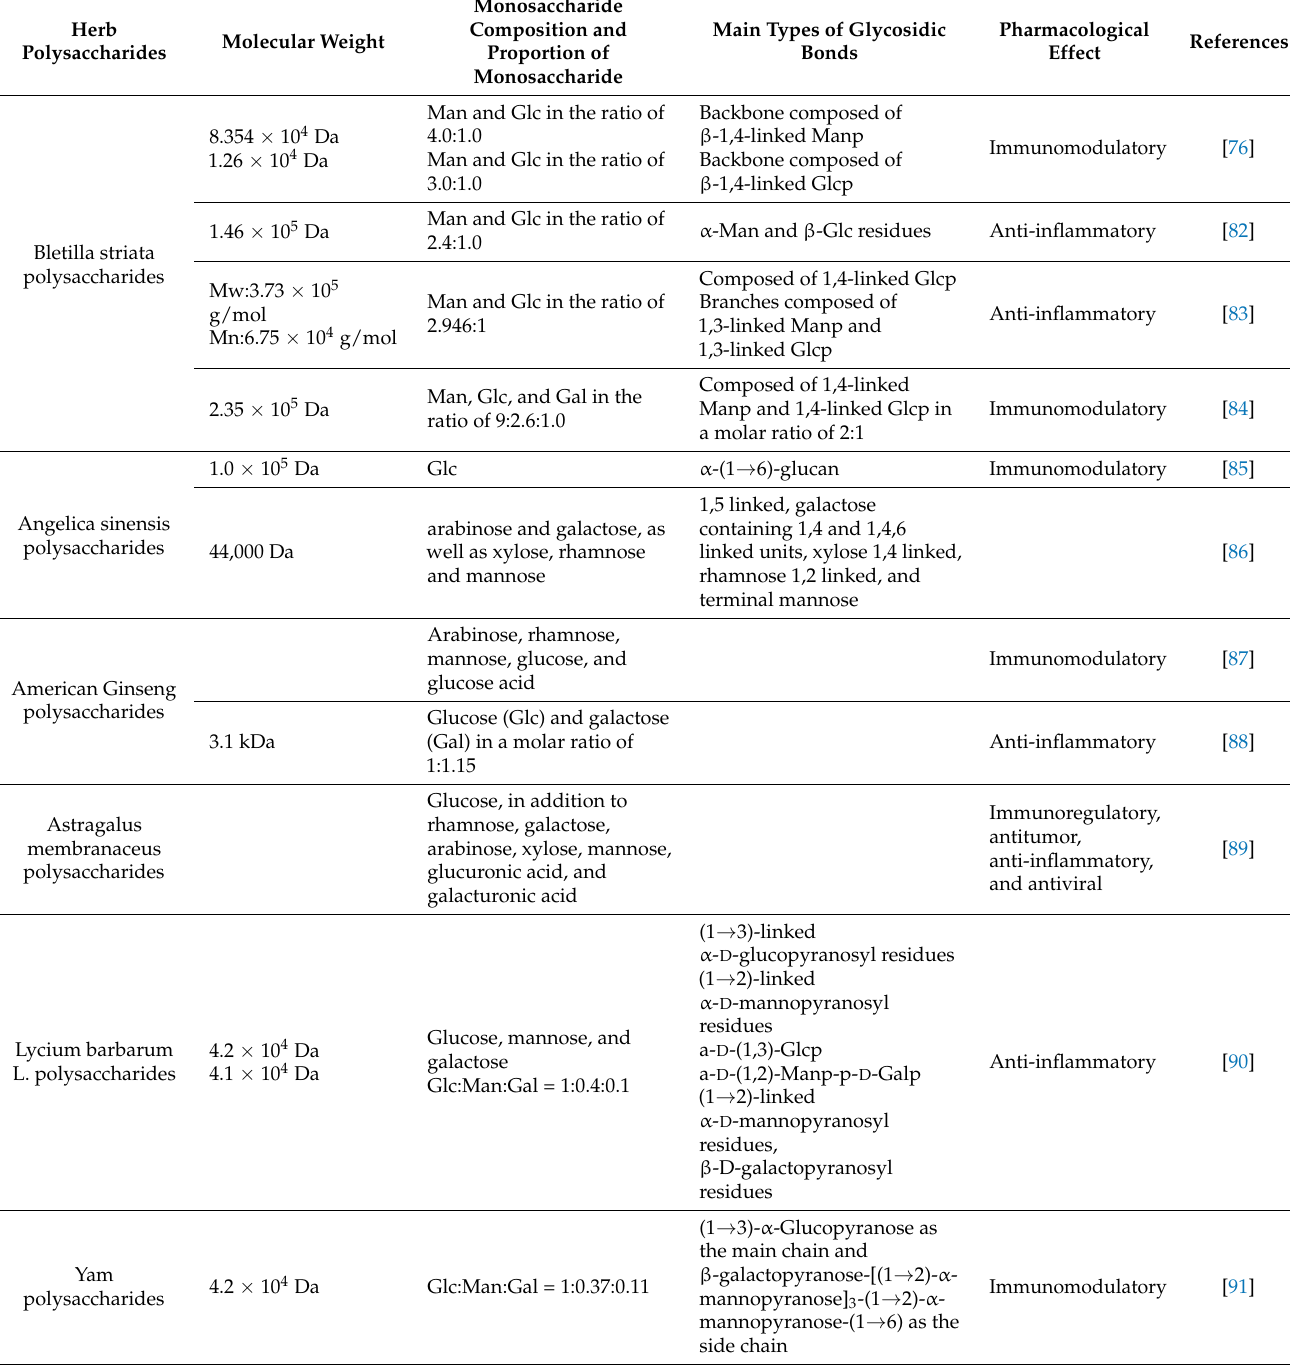
Table 1. Summary of herb polysaccharides and their